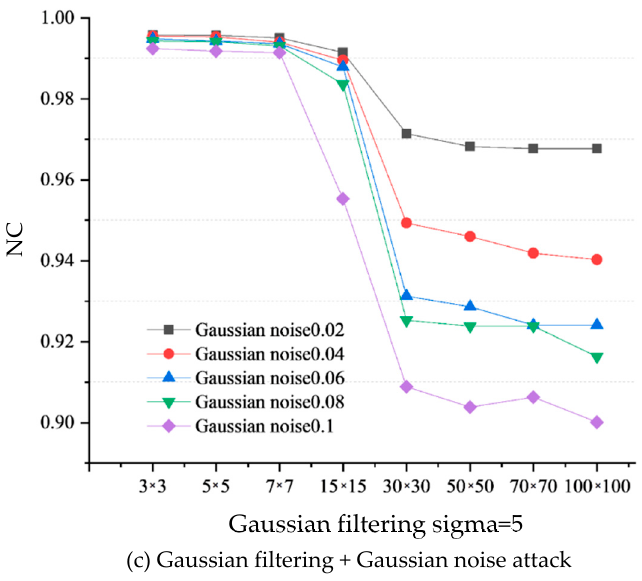
Figure 11. NC values under different combined attacks.